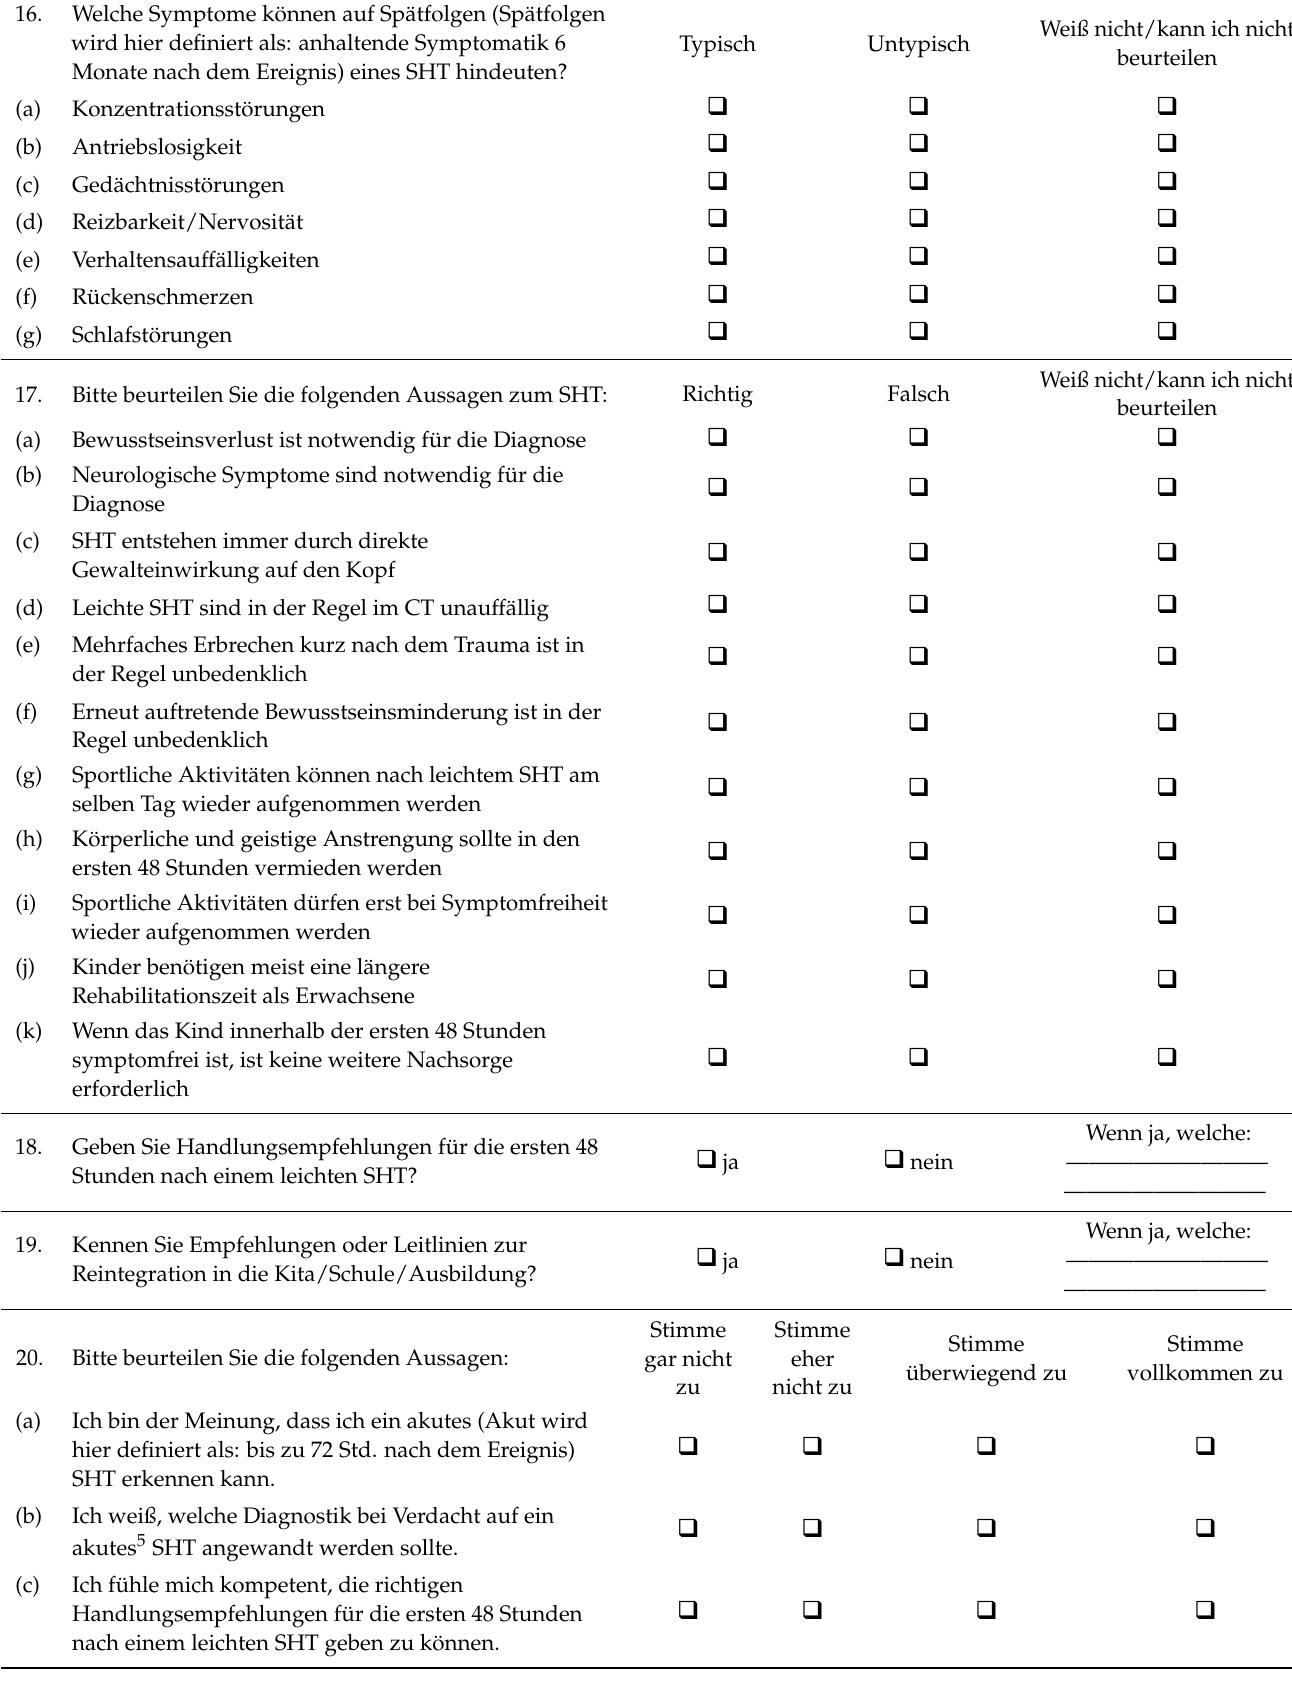
einsetzende Symptome aufgeklärt Welche Symptome sind typisch für ein